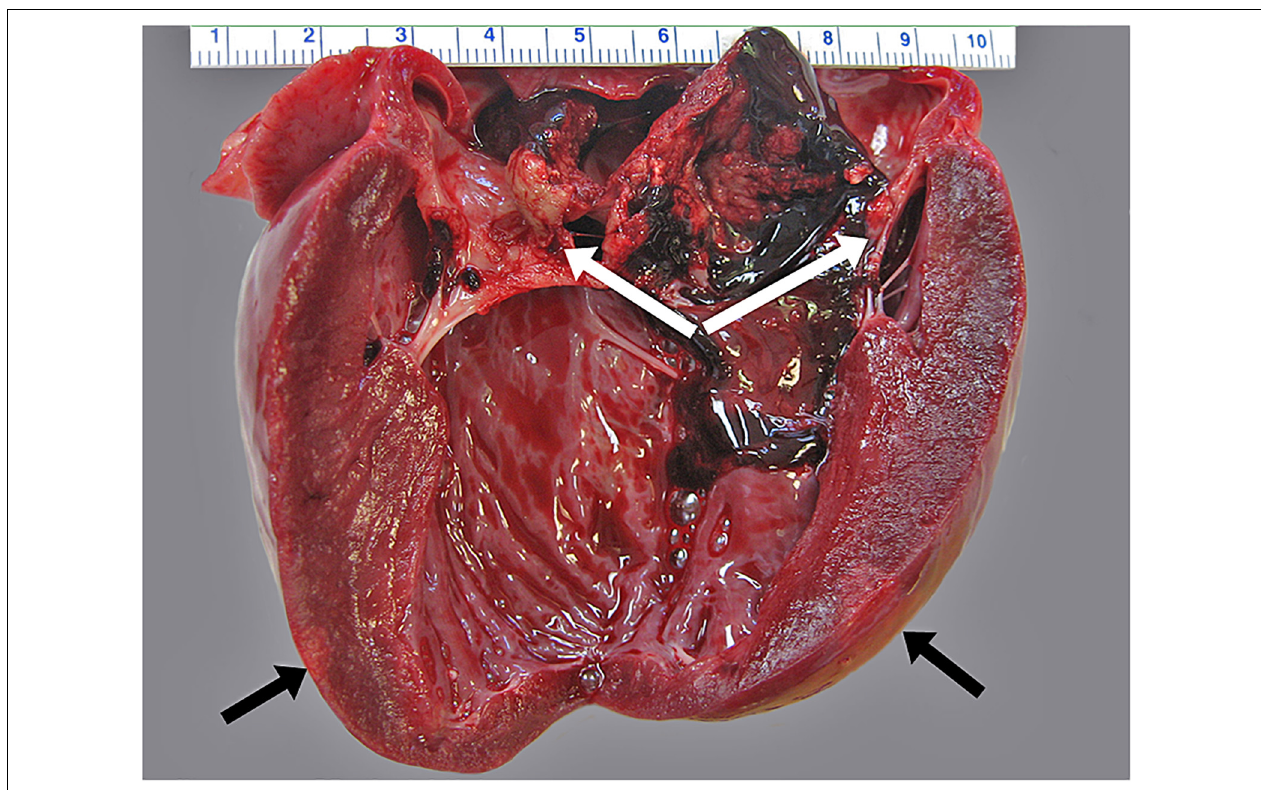
FIGURE 3 | Infectious endocarditis characterized by attachment of large, tan, and friable masses attached to the left atrioventricular heart valve (white arrows). Areas of pallor indicate myocardial infarction indicated by black